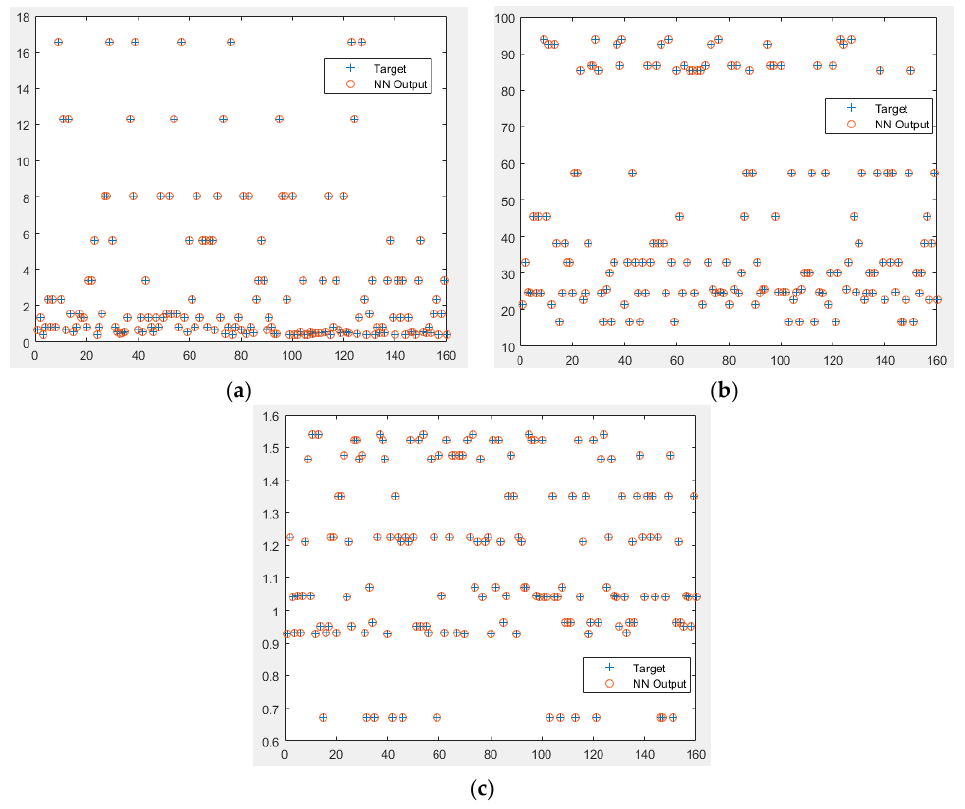
Figure 5. Validation results for Output 1 Partition Coefficients ( K pa) ( a ); Output 2 Recovery Yield (%) ( b ); and Output 3 Purification Factor (PF) ( c ).